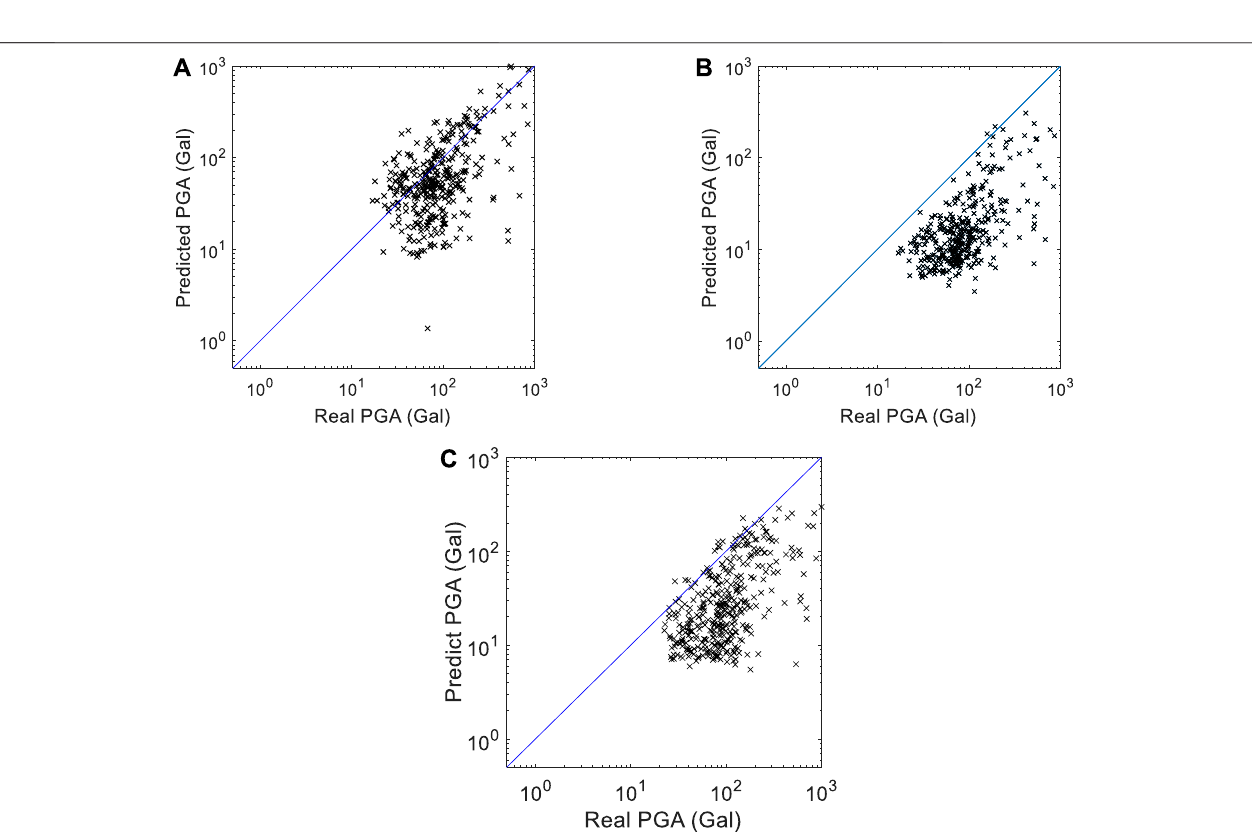
FIGURE11| ComparisonbetweenthepredictedPGAandactualPGAoftheChi-Chidatasetusing (A) theproposedLSTMapproach, (B) theSVRapproach,and (C) the CNN approach.